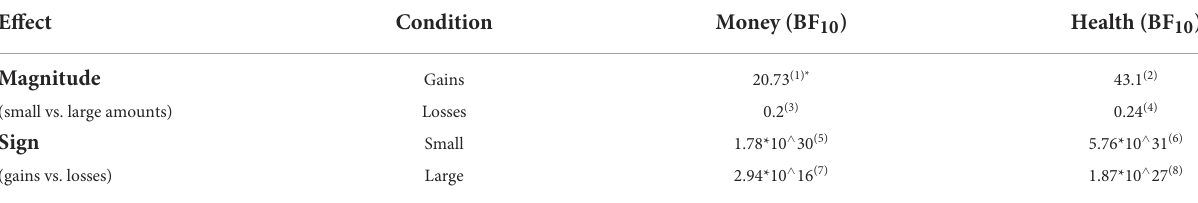
TABLE 1 Post-hoc comparisons for Bayesian RM ANOVA presenting Bayes factors for each comparison.